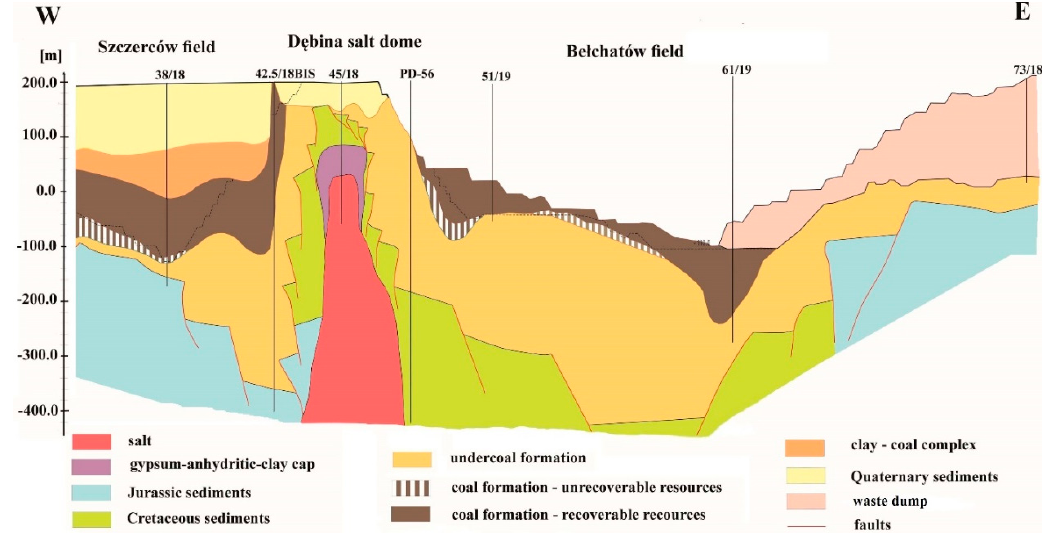
Figure 2. Geological cross-section of the DSD and adjacent sediments (based on [29,30]).